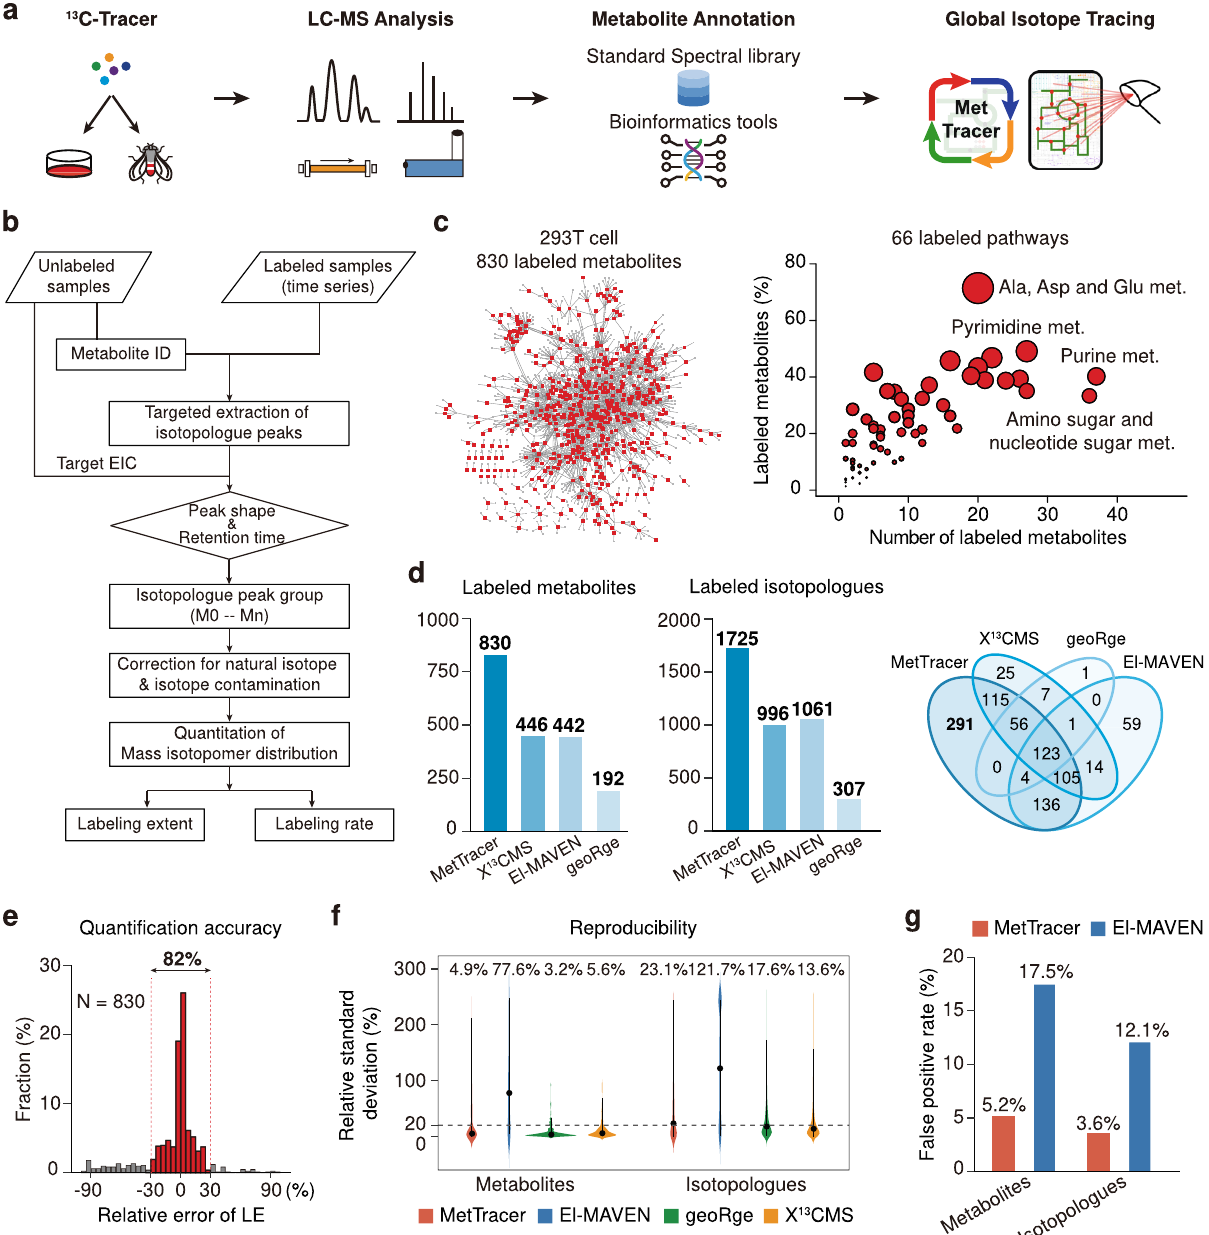
Fig. 1 Global stable-isotope tracing metabolomics. a Schematic illustration of MetTracer work fl ow. b Detailed data processing work fl ow in MetTracer. c Distributions of the 830 labeled metabolites in 293T cells in the metabolic network (left panel) and pathways (right panel). Red dots in the left panel represent the labeled metabolites. The circle size in the right panel represents the ratio of the number of labeled metabolites to the number of metabolites in a pathway. d Numbers of labeled metabolites and isotopologues using MetTracer and other indicated software tools. The Venn diagram shows the overlap of the labeled metabolites using MetTracer and other software. e Distribution of relative errors of labeling extent values between MetTracer and manual analysis using Skyline ( n = 830 metabolites). f Relative standard deviation (RSD) distributions of metabolites and isotopologues obtained from MetTracer and other software tools ( n = 6 technical replicates of 293T cell samples). The black dots represent median RSD. g False-positive rates of the labeled metabolites and isotopologues obtained from MetTracer and El-MAVEN. Source data are provided as a Source Data fi